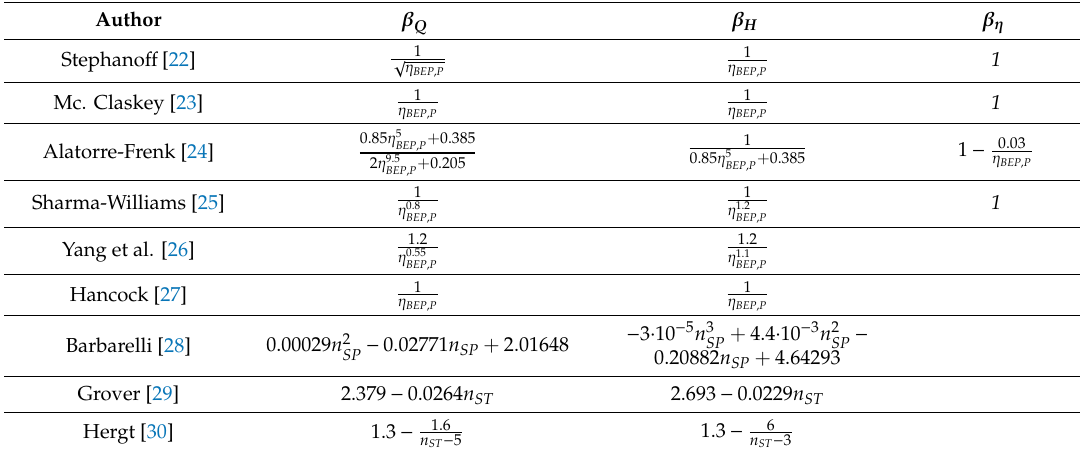
Table 5. Proposed empirical equations to predict conversion coe ffi